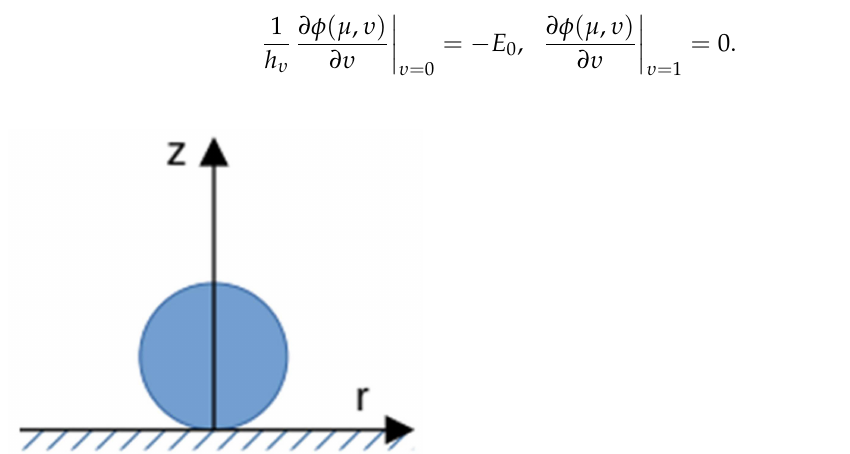
Figure 3. Schematic description of the problem in Section 6 of a spherical particle next to a wall ( z = 0), which is subjected to a uniform DC electric field acting in the z